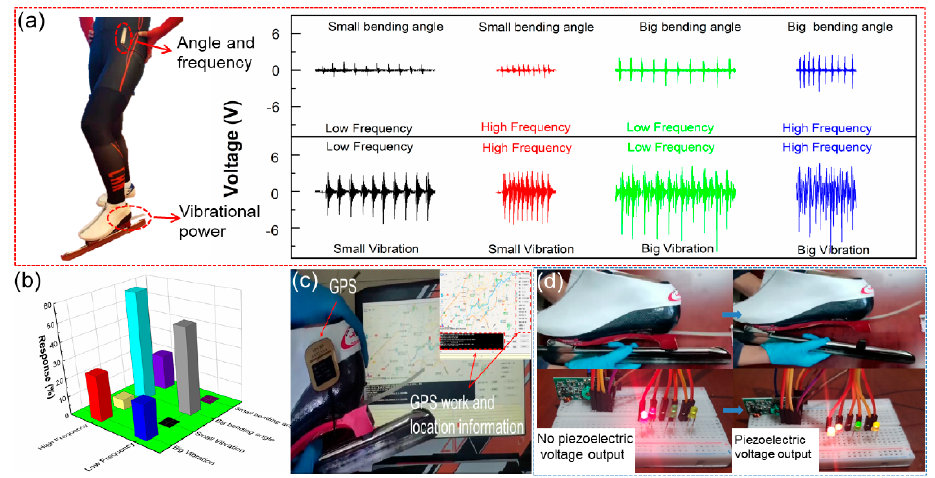
Figure 5. ( a ) Output piezoelectric voltage of speed skating during four sport states; ( b ) response of the sensor; ( c ) position information recorded by GPS system; ( d ) a simple wireless system for monitoring motion state.